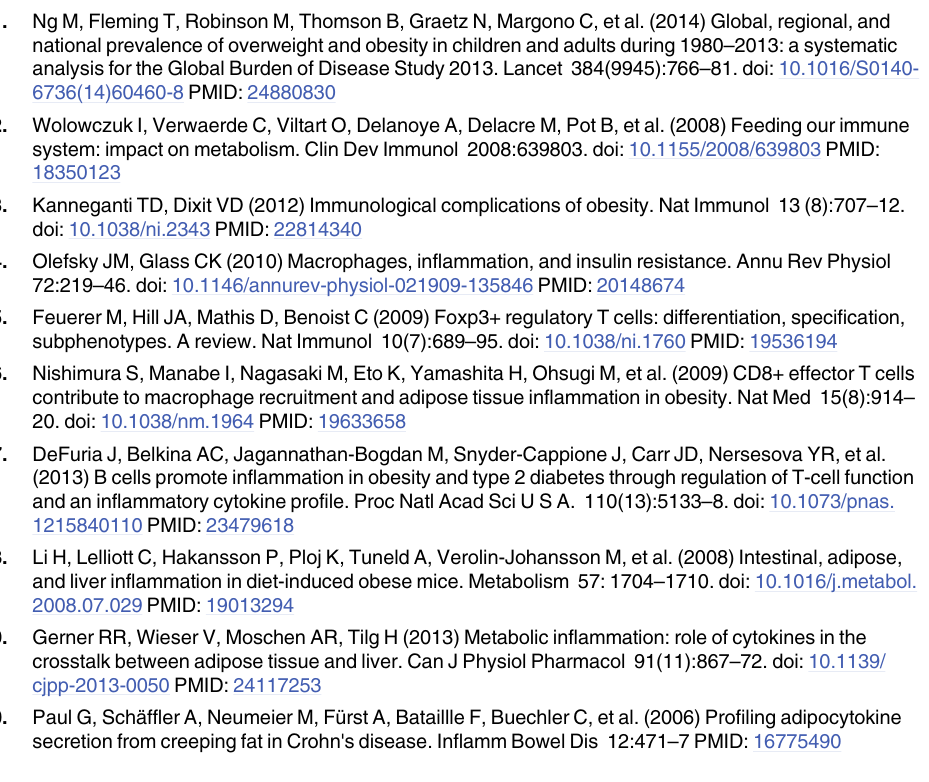
S2 File. Hepatic steatosis graded according to lipid accumulation in hepatocytes (Table). and examples of histologic analysis of hepatic steatosis in different mouse groups after 14 weeks of intervention (Figure).